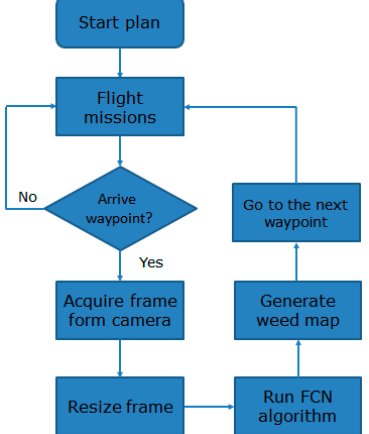
Figure 3. Overall workflow for image collection and processing.